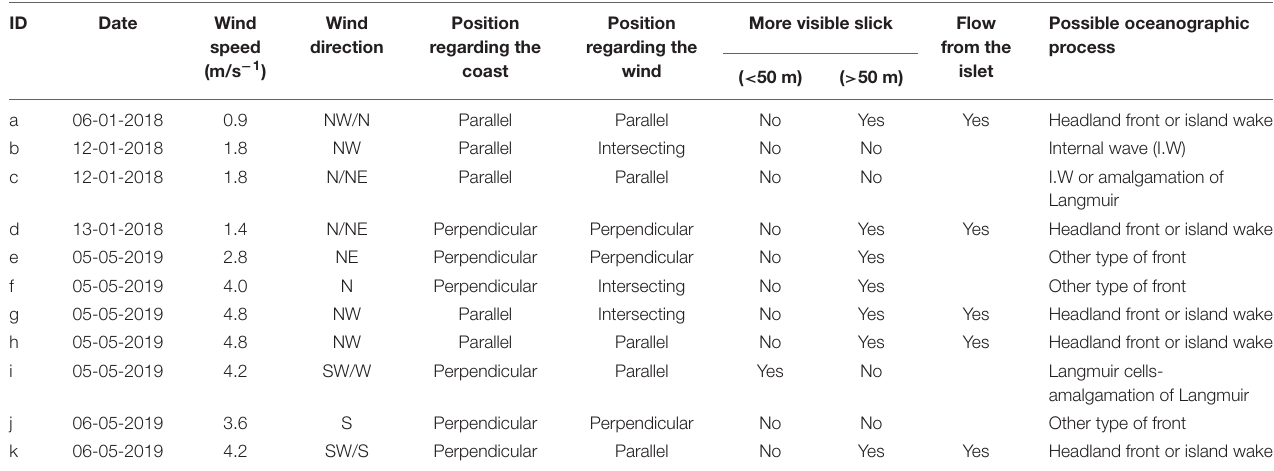
TABLE 1 | Characteristics of the